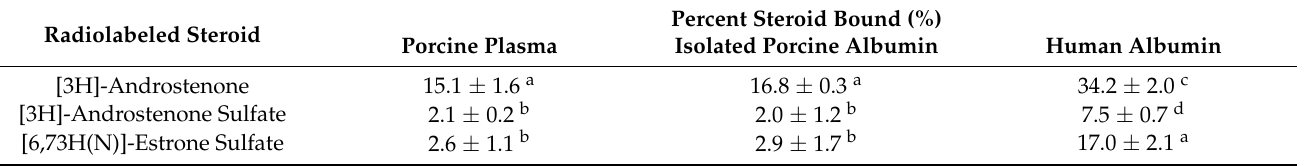
Figure 2. A graph showing the binding of free androstenone (red), androstenone sulfate (blue), and E 1 S (green) to human serum albumin following HPLC gel filtration. Bound and unbound steroid peaks are represented by A and B, respectively. Values are expressed as the mean from three separate experiments. Table 1. Binding of Radiolabeled Steroids to Porcine Plasma and Human Albumin .